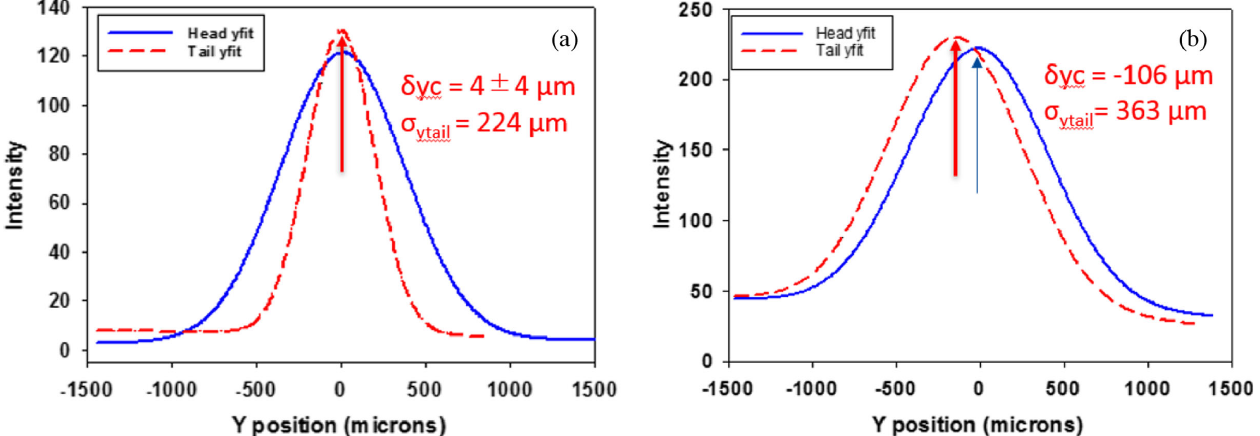
FIG. 7. (a) Comparison of the Gaussian fits to the profile taken at the head and the tail of an image with HOMs minimized and a laser spot of 1.2 mm rms. (b) Comparison of the Gaussian fits to the profile taken at the head and the tail of an image with V 103 ¼ − 2 A ð − 4 mrad Þ from the reference. A clear centroid shift of − 106 μ m is seen, and a > 50 % larger profile of 363 μ m at the tail is seen than in